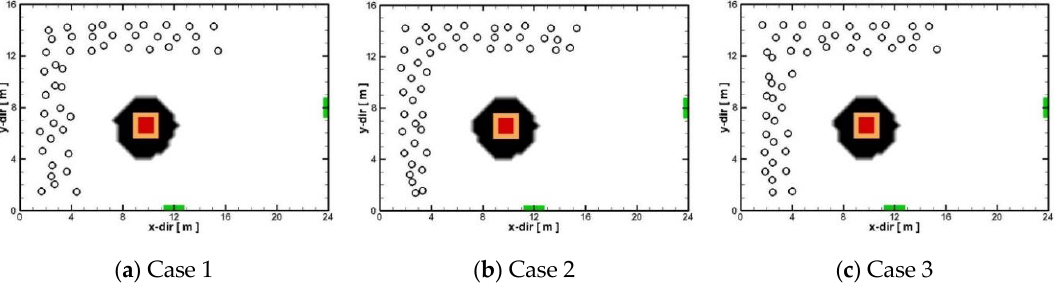
Figure 2. The distribution of the evacuees at 2 s.